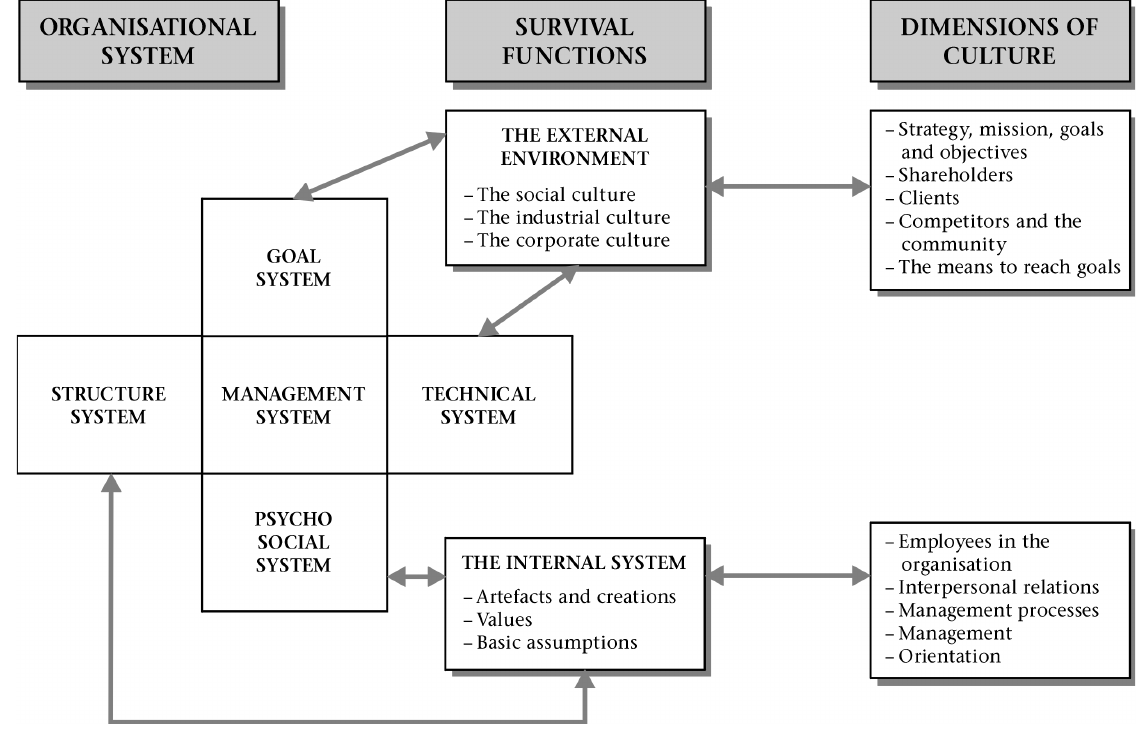
Figure 2:A Model of Organisational